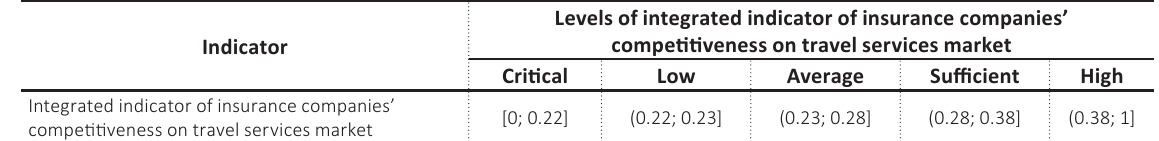
Table 3. Scales of insurance companies’ competitiveness on travel services market